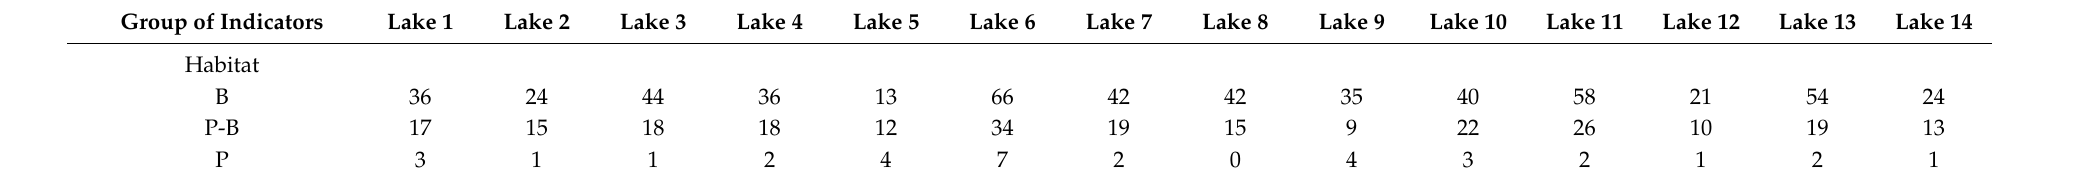
Table A4. Bioindicator spectrum for diatom communities of 14 studied water bodies in the vicinity of Tiksi Bay, July